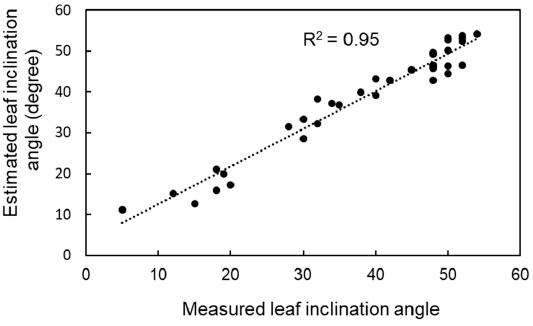
Figure 3. Relationship between measured leaf inclination angle and estimated leaf inclination angle (degree).